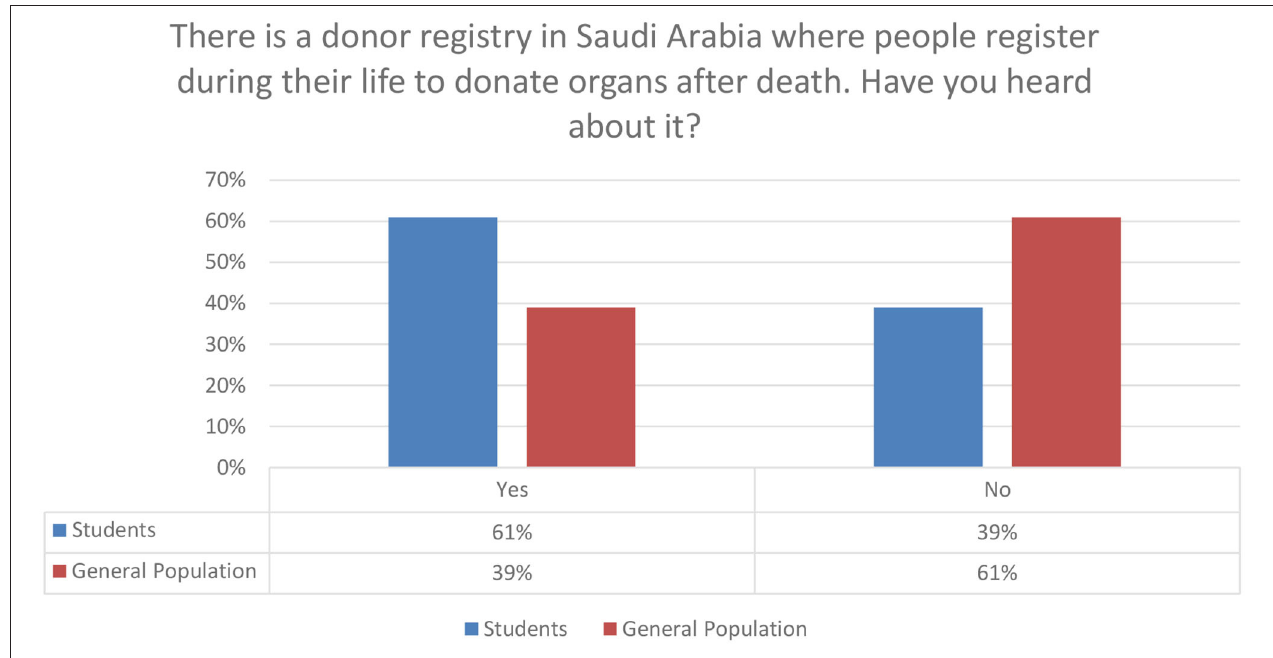
FIGURE 2 | Knowledge about donor registry in Saudi Arabia.